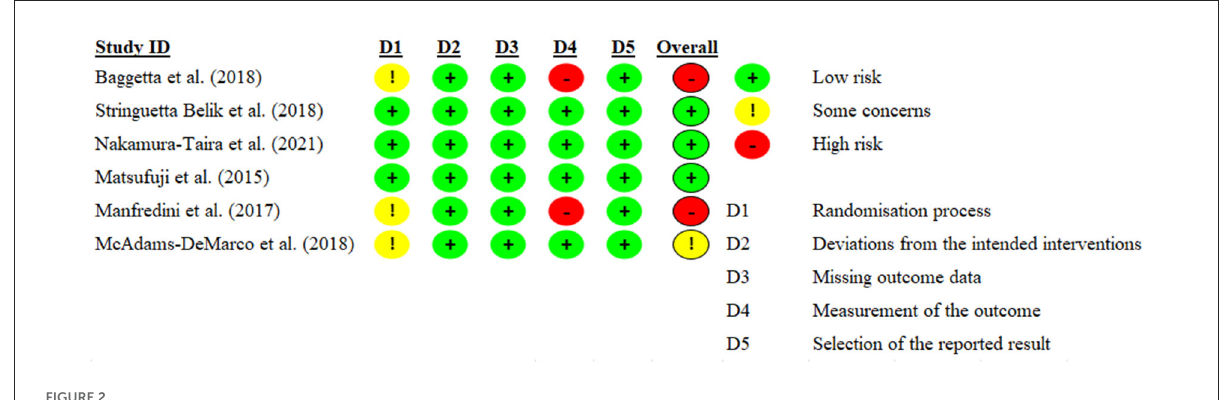
FIGURE2 Risk of bias